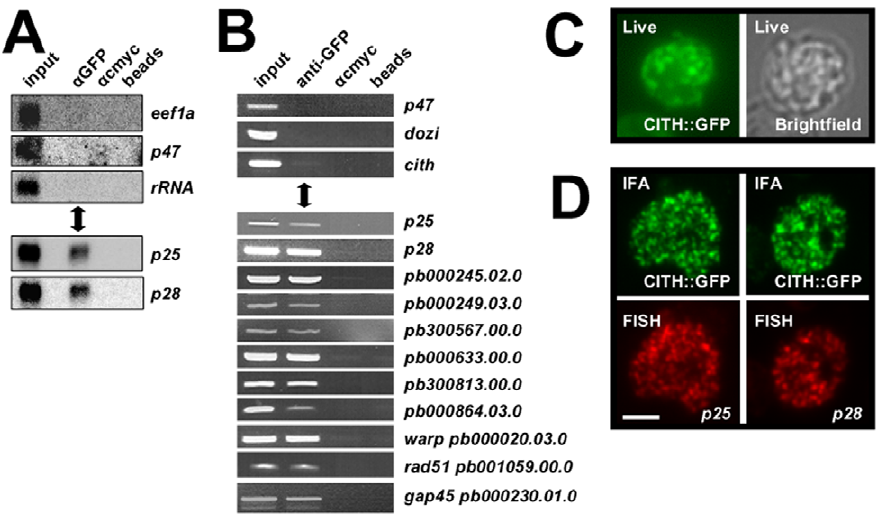
Figure 3. CITH co-localizes with translationally repressed mRNAs. A Northern analysis of CITH::GFP IP eluates show specific co-elution of translationally repressed mRNAs p25 and p28 , but not transcripts known to be translated ( p47 , eef1a ) or ribosomal RNA. Equivalent amounts of eluates and input were loaded. B RT-PCR analyses show specific enrichment of transcripts known to be translationally repressed in the anti-GFP pull down; transcripts of expressed proteins (P47, DOZI, CITH) are absent. C The CITH::GFP fusion protein is present in characteristic foci in the cytoplasm of live parasites. D Fluorescent in situ hybridization combined with immunofluorescence analysis shows overlapping signals for p25 and p28 mRNAs and CITH::GFP. Scale bar =4 m